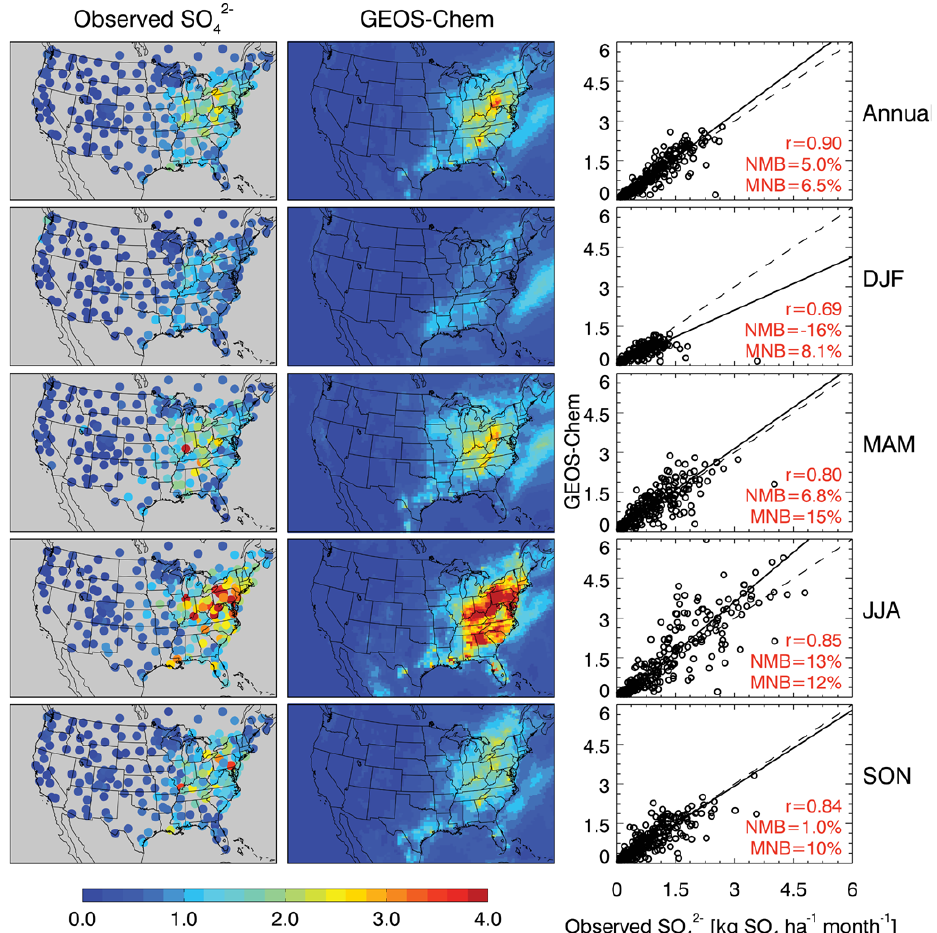
Fig. 3a. Annual and seasonal mean sulfate wet deposition fluxes measured at NADP and CAPMoN sites (left panels) and simulated by GEOS-Chem (central panels) in 2006. The right panels show scatter-plots of simulated versus observed values at individual sites. Correlation coefficients ( r) , normalized mean biases (NMB), and mean normalized biases (MNB) are shown inset. Reduced-major-axis regression lines (solid) and the 1:1 lines (dash) are also